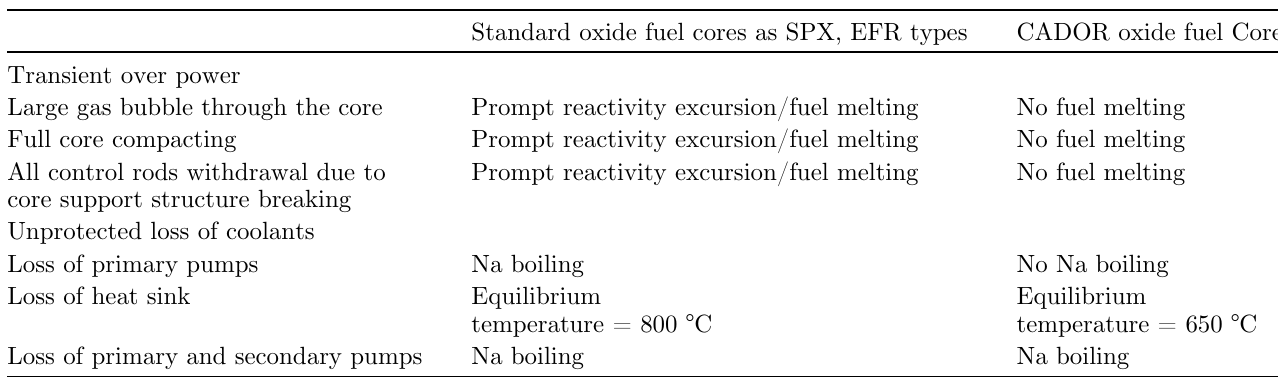
Table 4. Global performance comparison between the different types of cores.